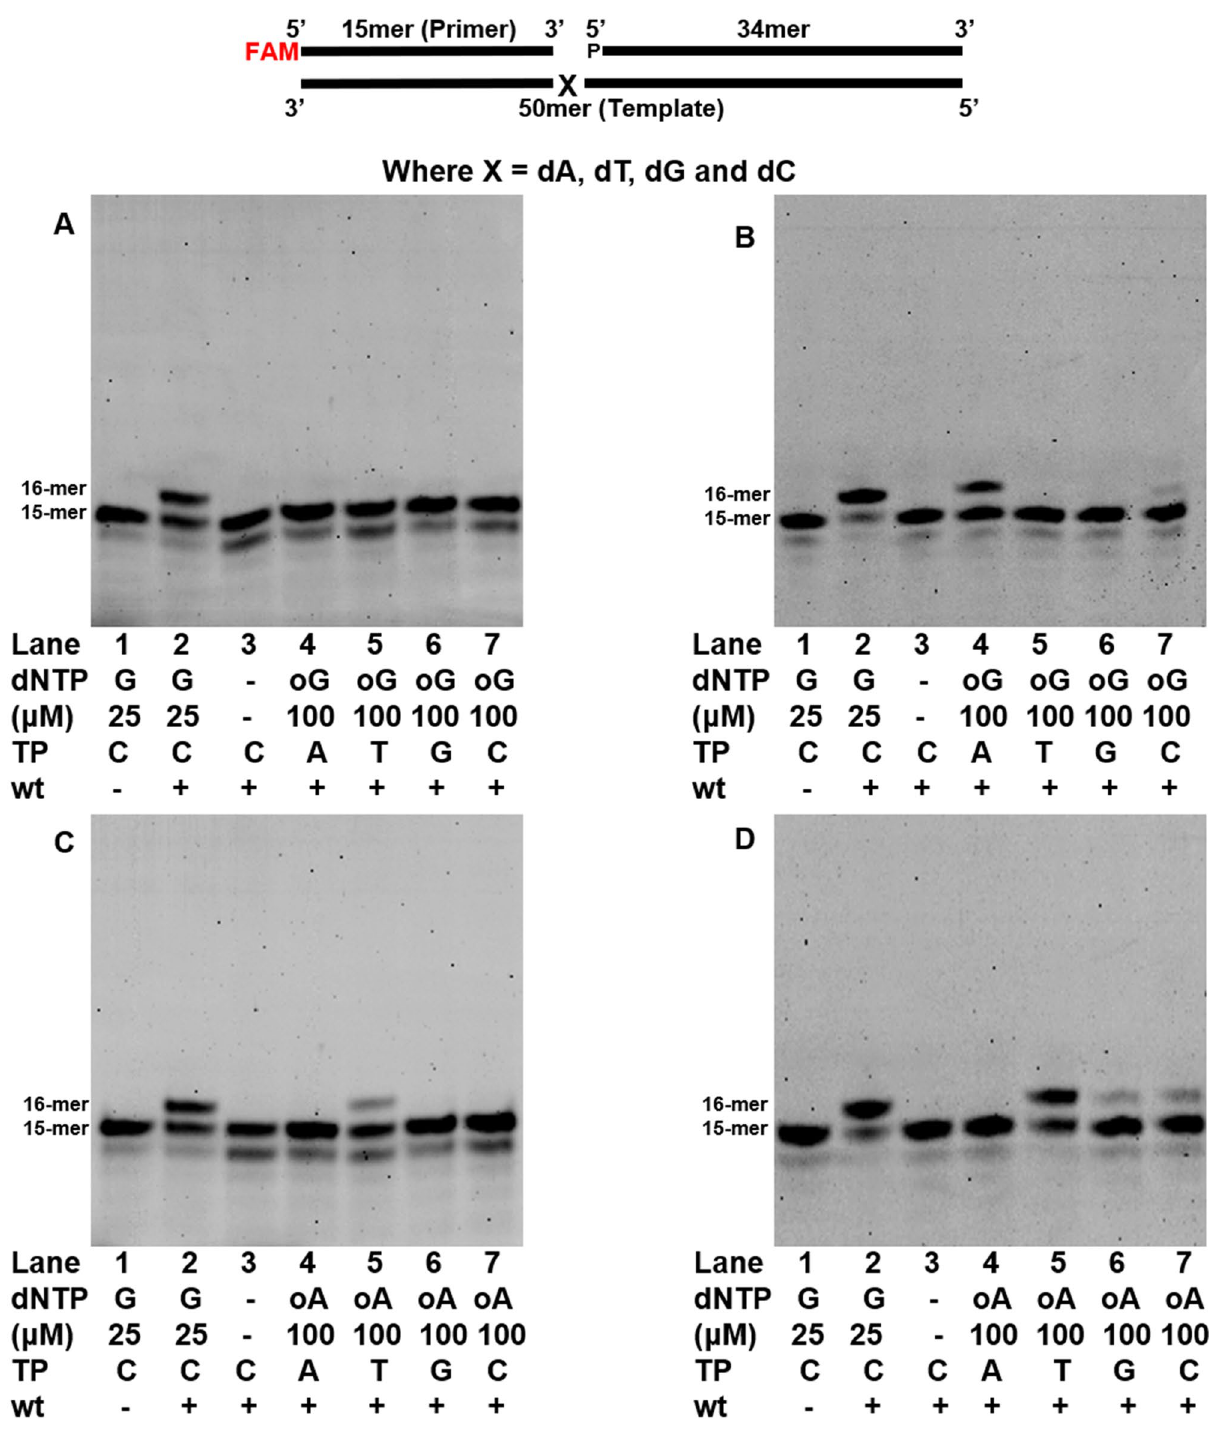
Figure 8. Comparison of incorporation of oxidized nucleotides by wt and mutant versions of saPolX. The incorporation of 8oxodGTP (oG) opposite all four possible templating deoxynucleotides was compared to the incorporation of dGTP opposite dC for ( A ) wt-saPolX and ( B ) mutant H435A. Whereas wt-saPolX does not incorporate 8oxodGTP at all, H435A incorporates 8oxodGTP preferentially opposite template dA instead of dC. The incorporation of oxidized nucleotide 2-OH-dATP (oA) opposite all four possible templating deoxynucleotides was compared to that of incorporation of dGTP opposite dC for ( C ) wt-saPolX and ( D ) mutant H435A. The native enzyme incorporated 2-OH-dATP opposite dTTP but the mutant version misincorporated the damaged nucleotide opposite template dG and dC